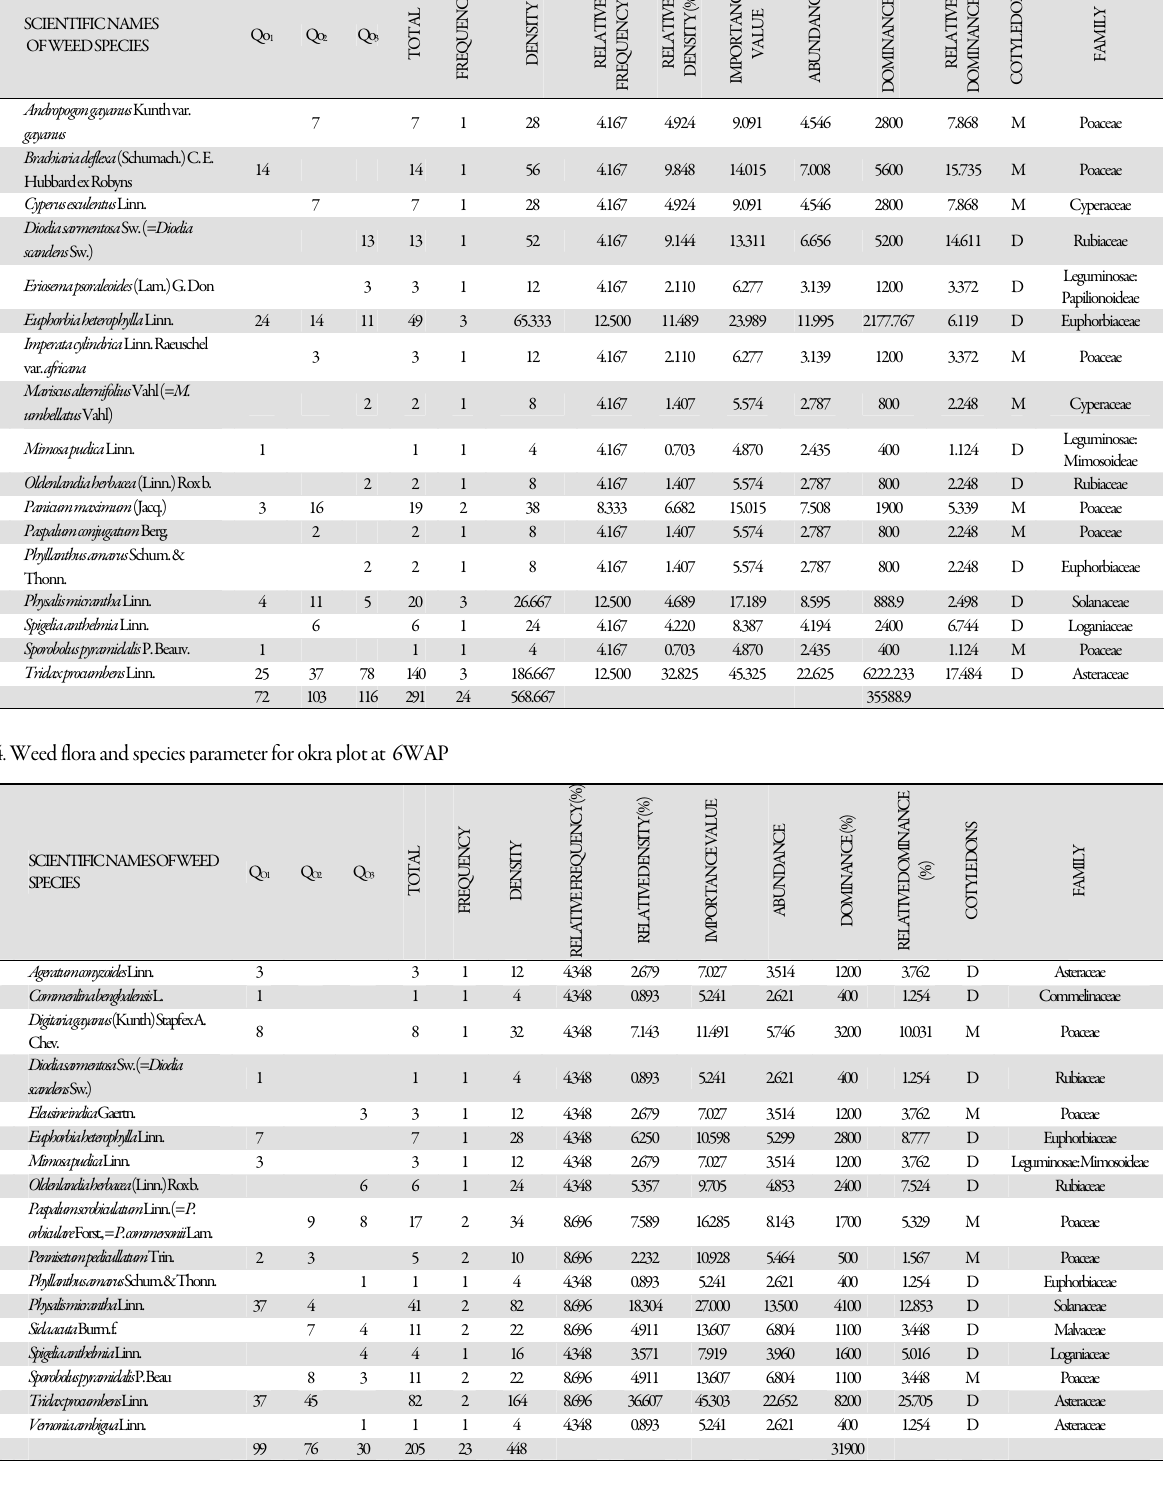
Tab. 3. Weed flora and species parameter for okra plot at 3WAP